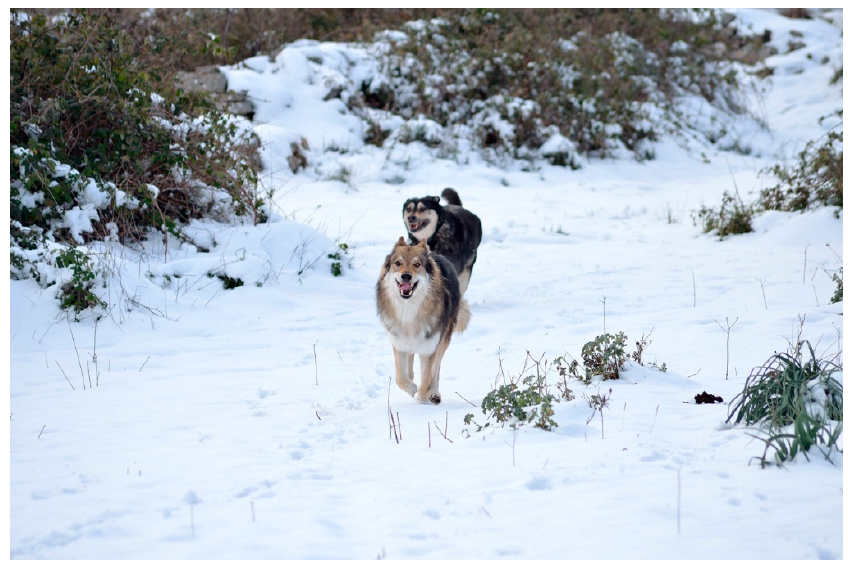
Figure 5. The Czech wolf is positively excited during play; his facial muscles are not in tension and his eyes are “soft”.